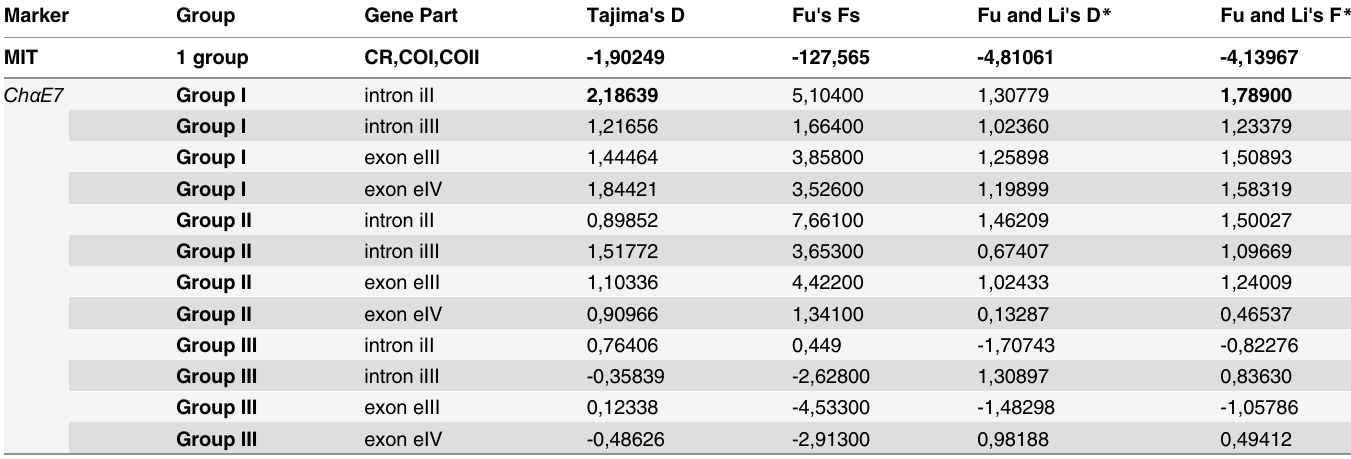
Table 5. Neutrality tests for mitochondrial (MIT) and Ch α E7 sequence